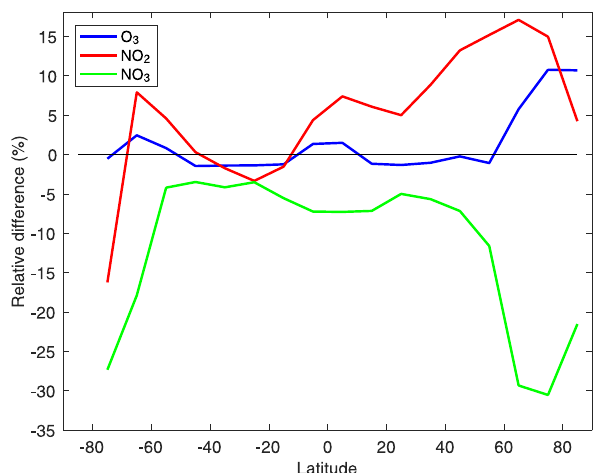
Figure 21. The relative difference of WACCM and GOMOS ver- tical columns of ozone, NO 2 and NO 3 . The vertical extent of the column is 0.0002–50hPa for ozone, 0.4–37hPa for NO 2 and 1.1– 26hPa for NO 3